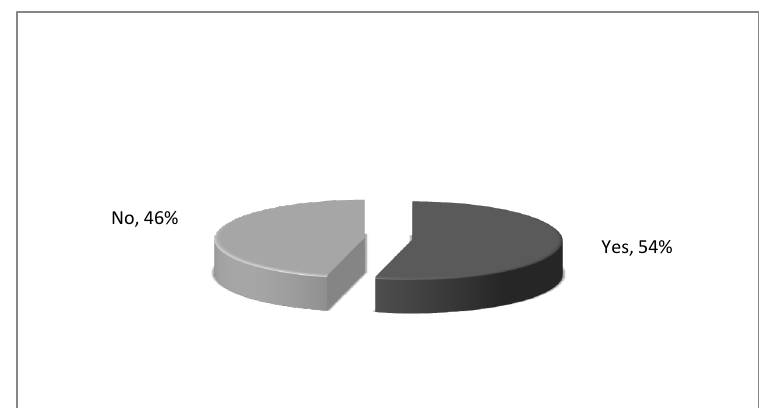
FIGURE 6: Respondents’ awareness of the existence of the Basic Conditions of Employment Act, 2008 Source: Survey data